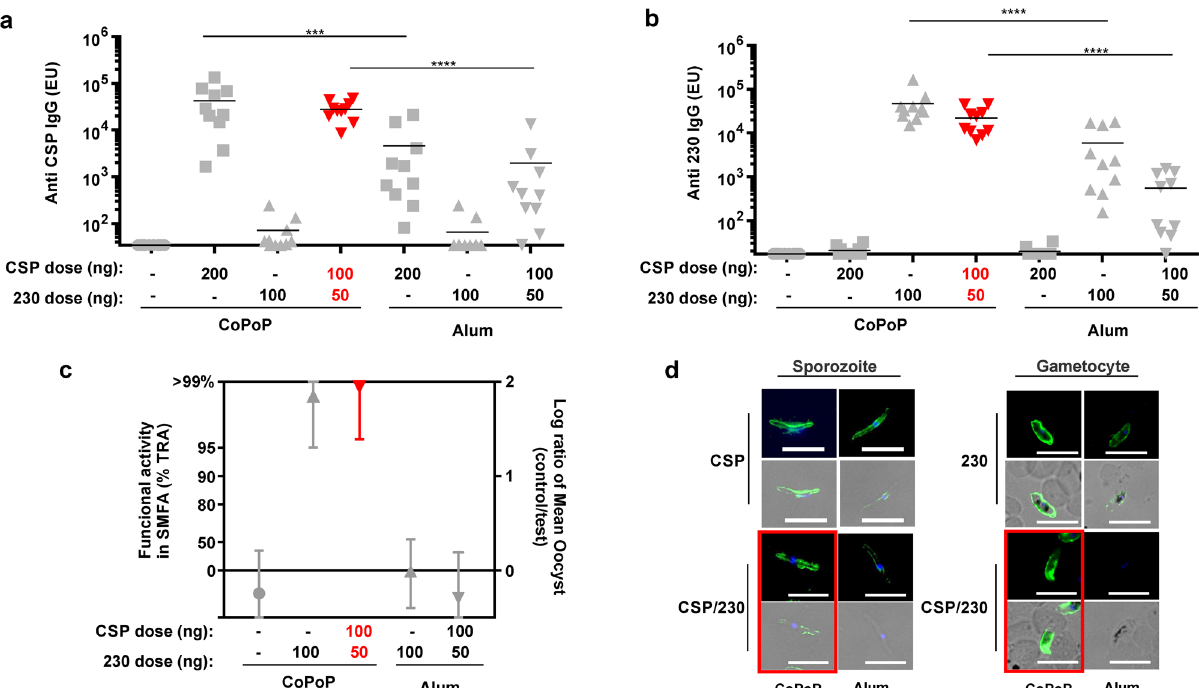
Fig. 4 Bivalent CSP and Pfs230D1 + immunization of outbred mice. ICR mice were immunized with CSP, Pfs230D1 + or bivalent antigens with CoPoP liposomes or alum on day 0 and day 21, fi nal bleeding were collected on day 42. a Anti CSP ELISA units (EU) and ( b ) Anti Pfs230D1 + EU. ELISA experiments were performed with n = 10 mice. For A and B, bars represent geometric mean, and one-way ANOVA followed by Tukey test using log- transformed data were used to compared difference among CSP/CP, CSP/230/CP, CSP/Alum and CSP/230D1/Alum for a and 230/CP, CSP/230/CP, 230/Alum and CSP/230/Alum for b . **** p < 0.0001, *** p < 0.001, ** p < 0.005. c Standard membrane feeding assay (SMFA) results of puri fi ed IgGs tested at 750 μ g/ml with complement. %TRA and the 95% con fi dence interval (95% CI) are shown. d Immuno fl uorescence assay of fi xed NF54 parasites at sporozoite and gametocyte stages. Bar: 10 µ m. Image was taken from a single experiment. Red symbols or outlines indicate bivalent, liposome-displayed